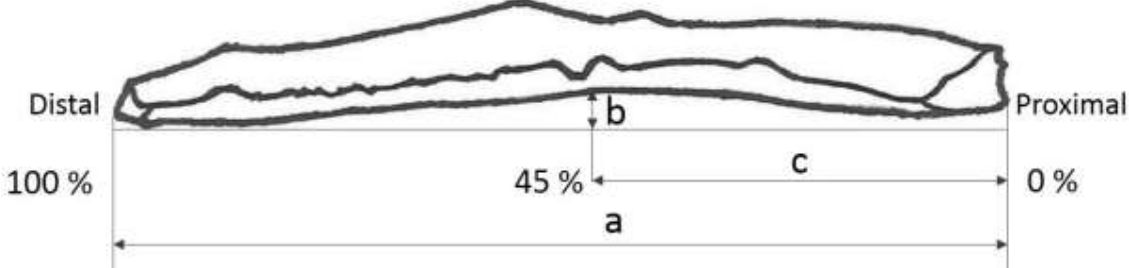
Figure 3. Measures for the calculation of the Index of Curvature (a and b) and the blade maximum curvature point (c). The Index of Curvature is calculated as b/a x 100. The maximum curvature point is a percentage estimated from proximal to distal end. Drawing by Nicolás Batalla, based on Boldurian & Hoffman (2009: fig. 7) and Collins (1999: fig. 7).